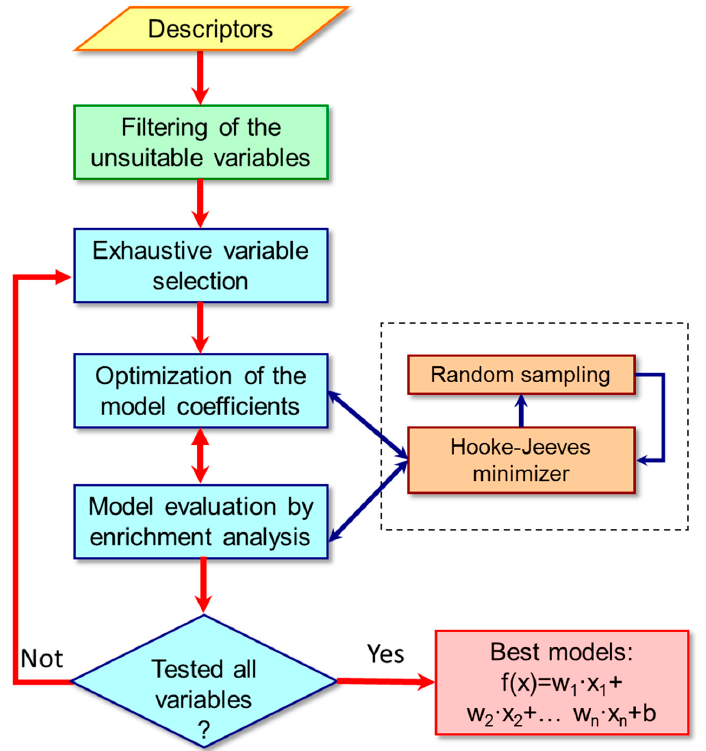
Figure 1. Main logical units into which the proposed classification algorithm can be subdivided. The yellow box indicates the input, the green box comprises the initial variable filtering; the blue boxes define the main tasks performed by the algorithm; the red box displays the obtained results. The brown boxes include the computational approaches by which each generated classifier is optimized by maximizing the corresponding quality function.